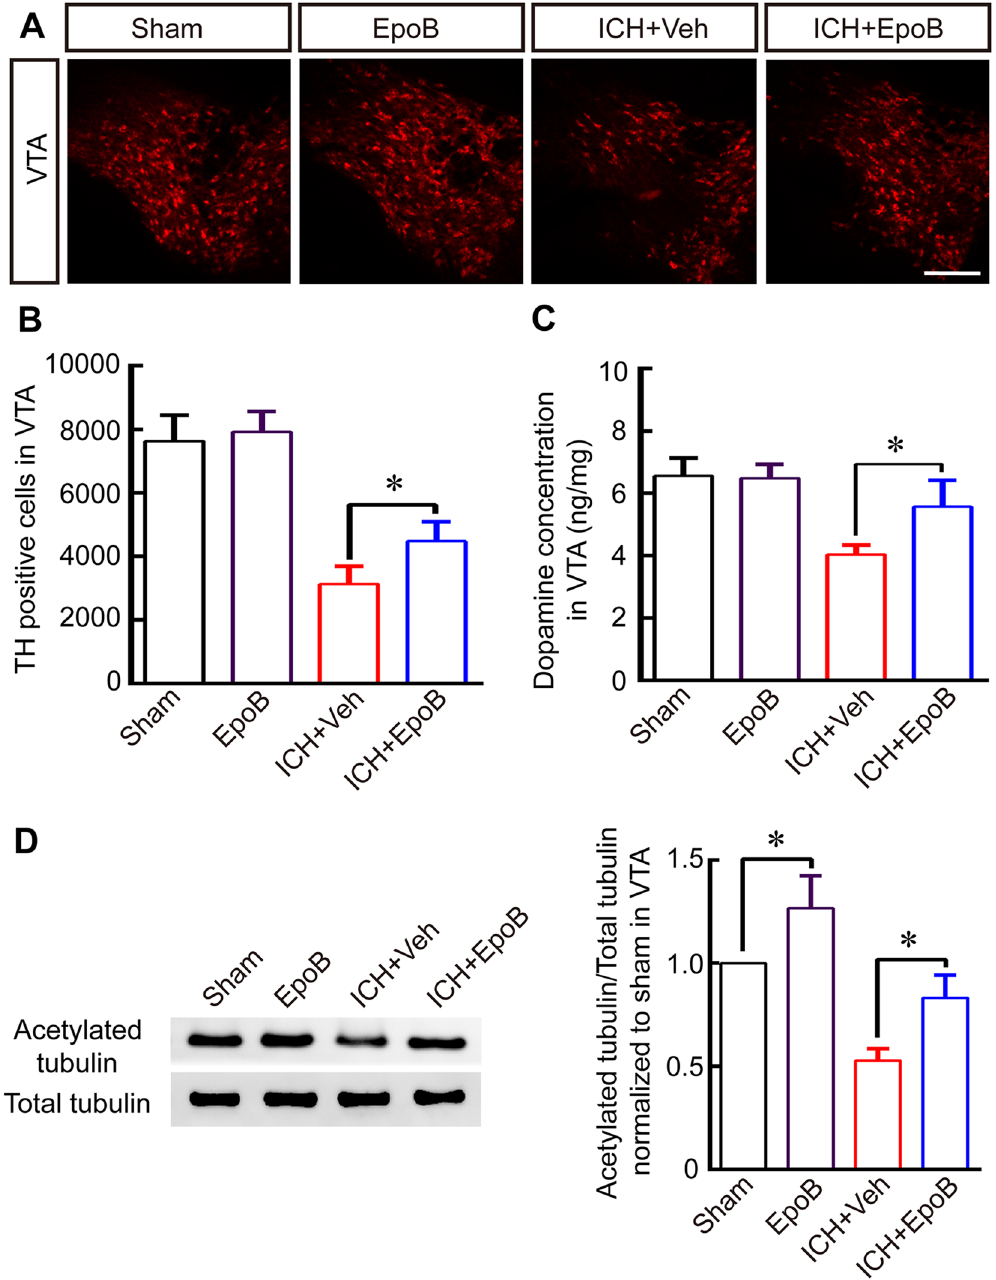
Figure 3. EpoB treatment rescues DA neurons and DA concentrations by promoting MT stabilization after ICH. ( A ) Representative immunofluorescence staining for TH in VTA in the Sham, EpoB, ICH + Veh and ICH + EpoB groups at 14 days after ICH (Scale bar = 100 μ m). ( B - C ) Quantitative data for TH-positive cell numbers ( B ) and dopamine concentrations ( C ) in the VTA in the Sham, EpoB, ICH + Veh and ICH + EpoB groups at 14 days post-ICH. ( D ) Representative Western blot images and quantitative data for acetylated α -tubulin and total tubulin expression in the VTA in the four groups at 14 days post-ICH (Full-length blots/gels are presented in Supplementary Figure S2). Data are shown as the means ± SEM (at least n = 5 for each group; * P <